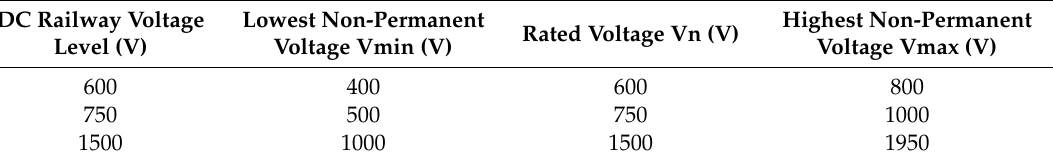
Figure 7. Current limitation of a traction train. Table 2. Permissible voltage limits for DC railways [42].